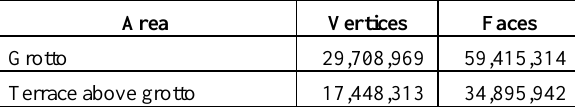
Table 3. Summary of meshes data